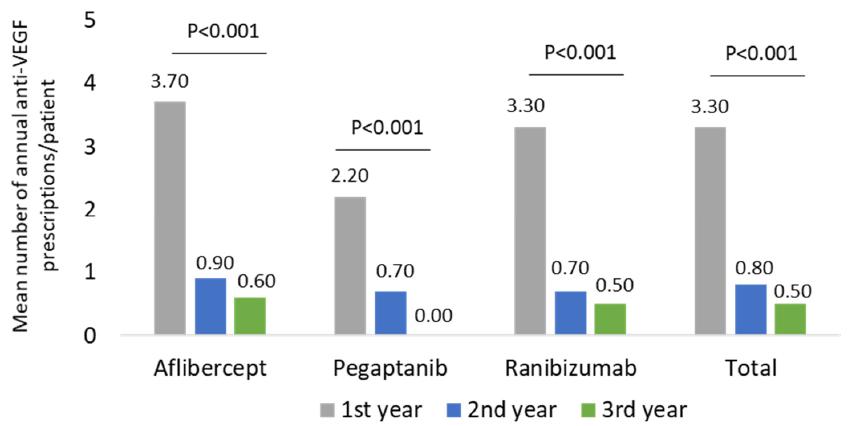
Figure 5. Mean number of annual anti-VEGF prescriptions/patient during the follow-up among other ocular disease-cohort patients.